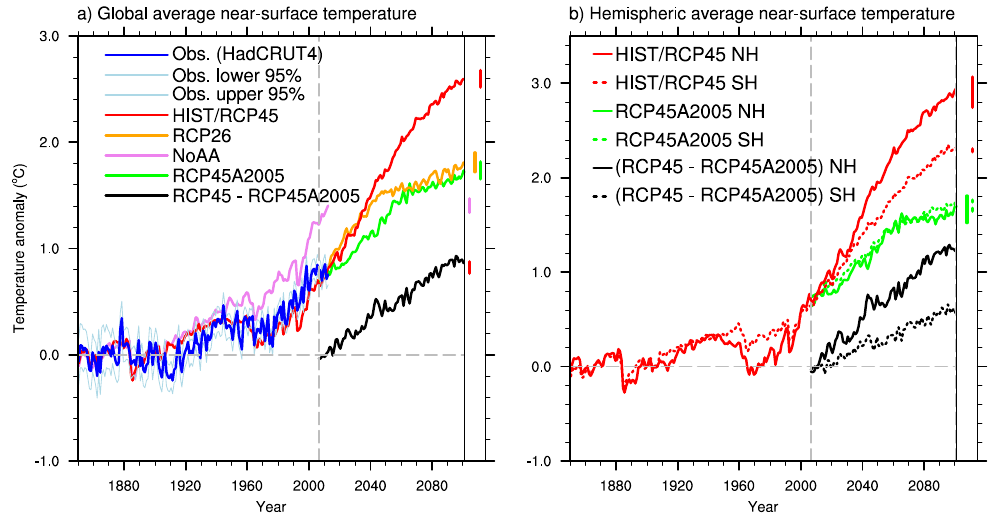
Fig. 6. (a) Anomalies (relative to the 1850–1899 mean) of annual-mean, ensemble-mean near-surface temperature: (a) global means, (b) NH and SH means. In panel a, the thick blue curve shows observations for 1850–2012 (HadCRUT4; Morice et al., 2012). The thin light blue curves denote 95% uncertainty bounds for the observations. In both panels, differences between RCP45 and RCP45A2005 are shown as black curves, and the vertical dashed line at 2006 marks the start of the projections. The vertical bars in the right inset show the standard deviations of the mean temperature from the last 10yr of each experiment (2091–2100 for the projections, or 2003–2012 for HIST and